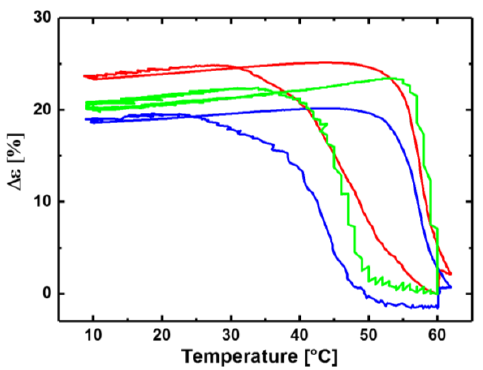
Figure 4. Comparison of reversible elongation of different cPCLs: cPCL 95 -L 05 (blue), cPCL 83 -L 17 (green), and cPCL 70 -L 30 (red). Table 3. Summary of reversible actuation properties of cPCL